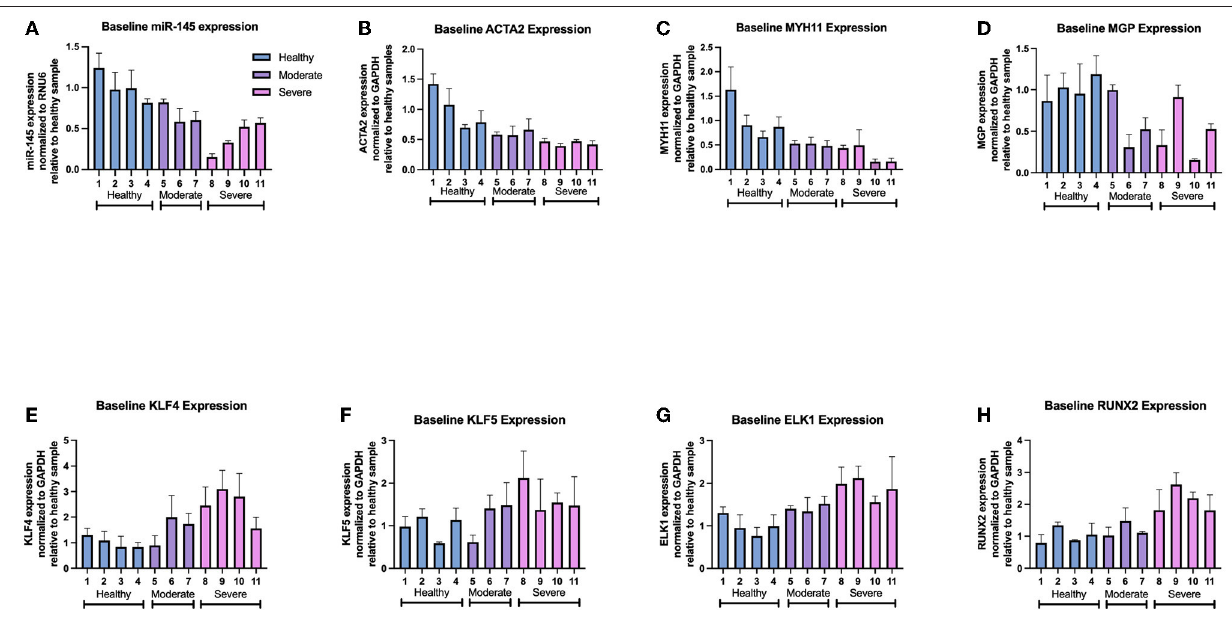
Frontiers in Digital Health |